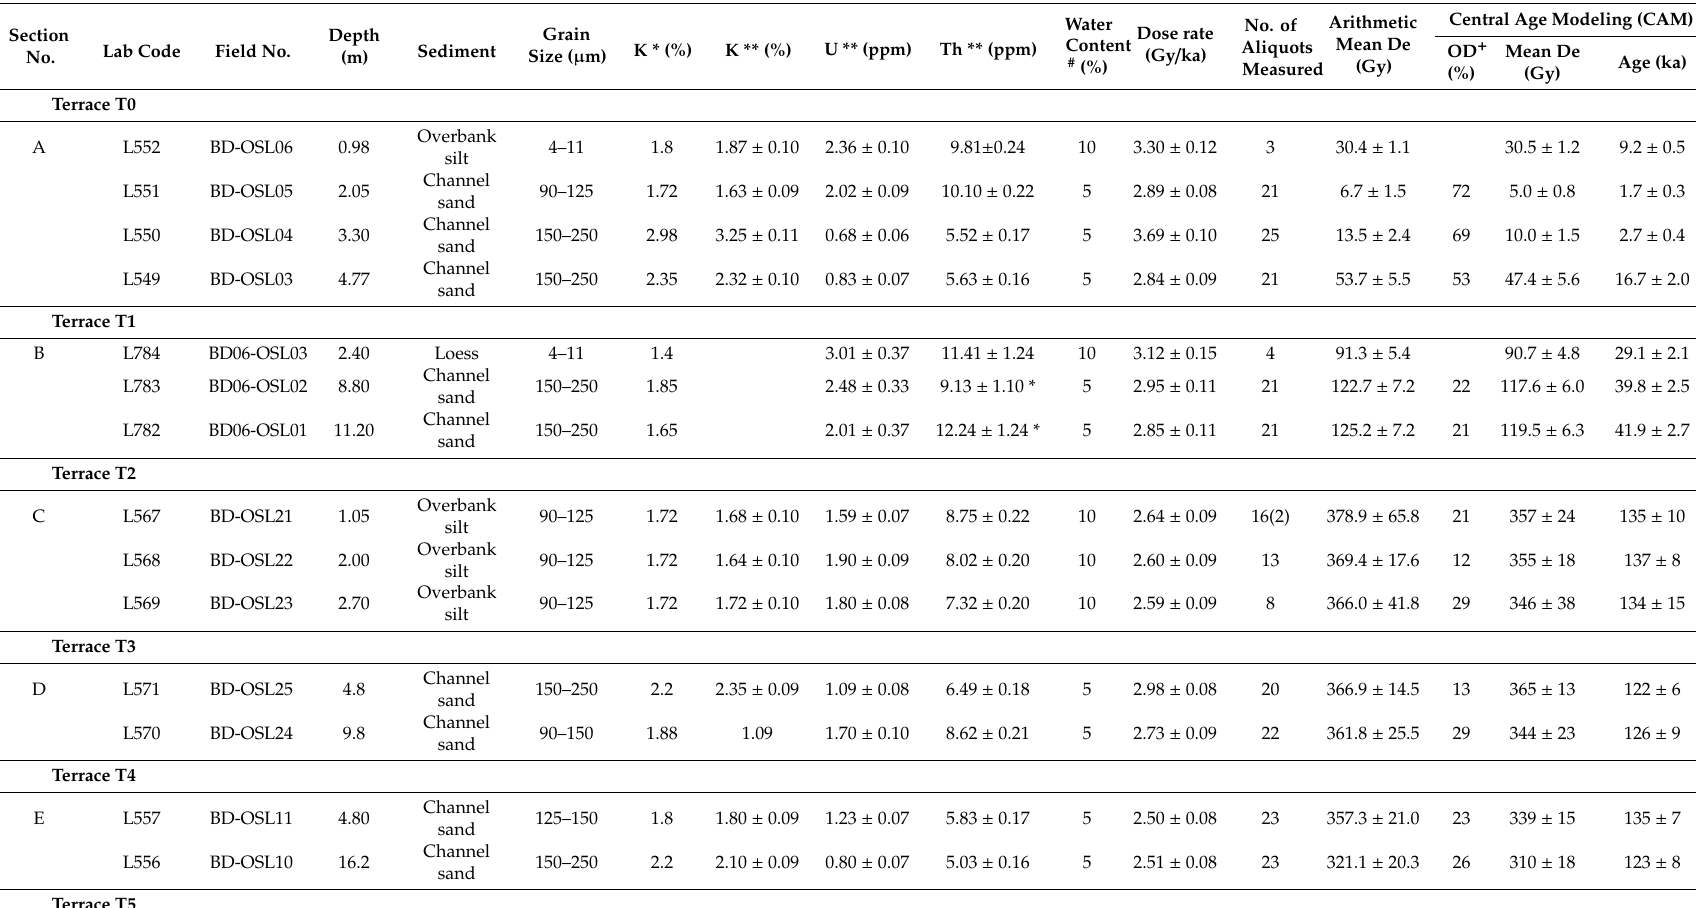
Table 1. The results of optical dating of the samples from the Yellow River terraces in the Baode area. Section